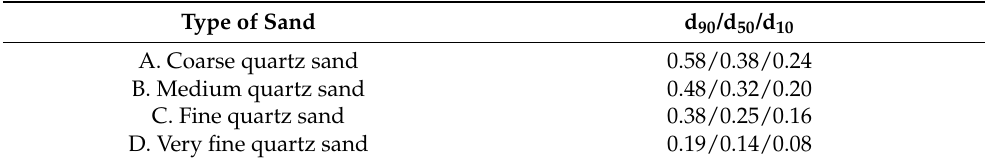
Table 4. Granulometric characteristics of the studied